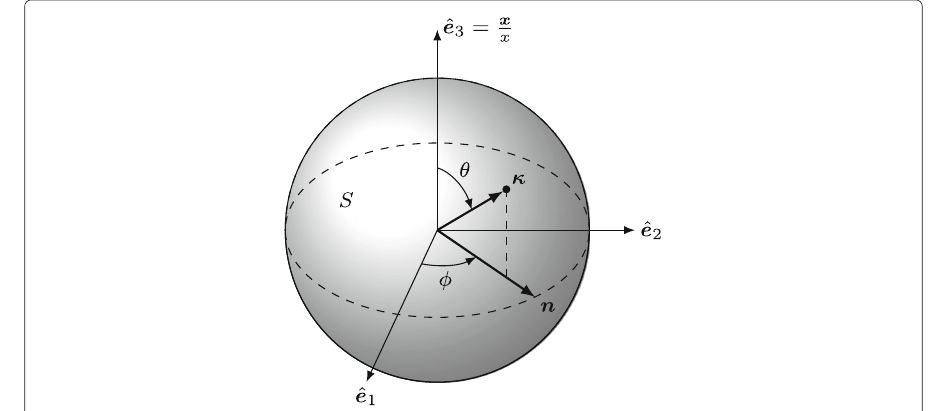
Fig. 1 The unit sphere in Fourier space. The unit vector κ (θ , φ) is defined by the azimuth angle φ , and the zenith angle θ measured from the axis ˆ e 3 = x /